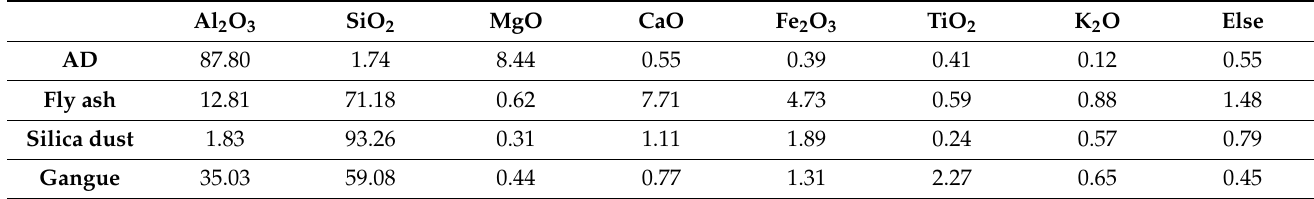
Table 1. Chemical composition of the raw materials